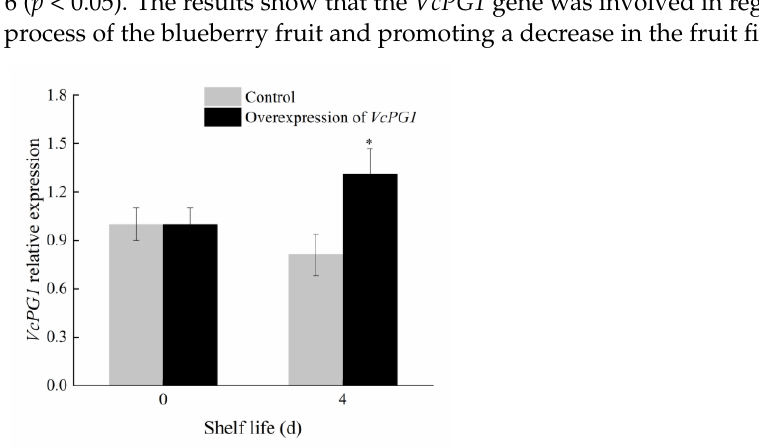
Figure 9. Effects of overexpression of VcPG1 on the morphology of blueberries at 20 °C. ( A ) Fresh blueberries (0 d). ( B ) Empty vector (20 °C, 6 d). ( C ) Overexpression of VcPG1 (20 °C, 6 d). The red frame indicates that after the overexpression of VcPG1 , the softening symptoms were enhanced. As can be seen in Figure 10, the firmness of the VcPG1 − overexpressed fruit was al- ways lower than that of the control fruit. The firmness of the control fruit was extremely significantly higher than that of the treated fruit on day 4 ( p < 0.01), and the sarcocarp firmness of the control was significantly higher than that of the treated fruit on days 4 and 6 ( p < 0.05). The results show that the VcPG1 gene was involved in regulating the softening process of the blueberry fruit and promoting a decrease in the fruit firmness.